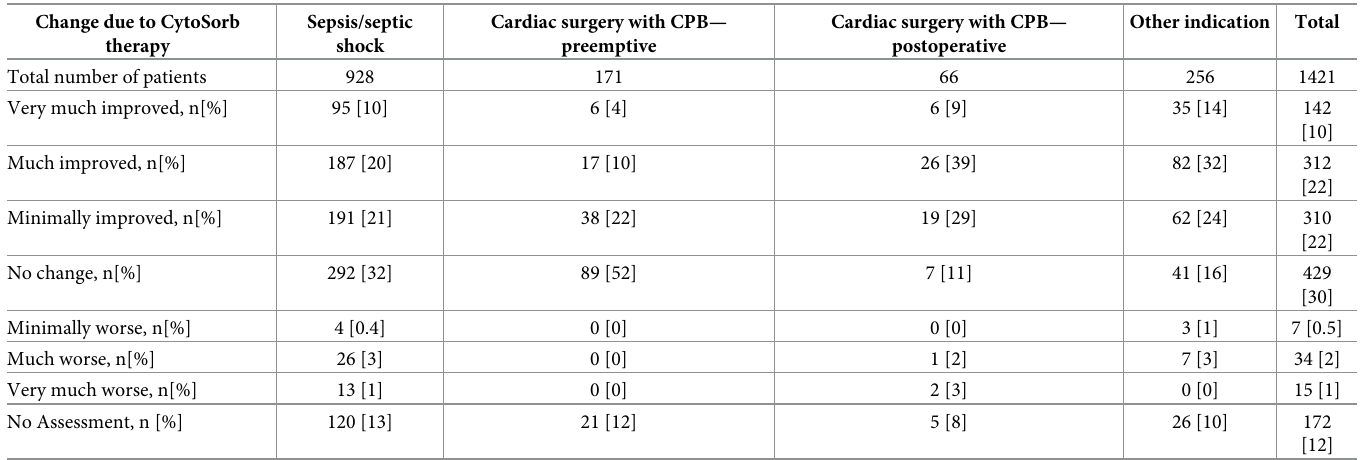
Table 3. Subjective assessment.